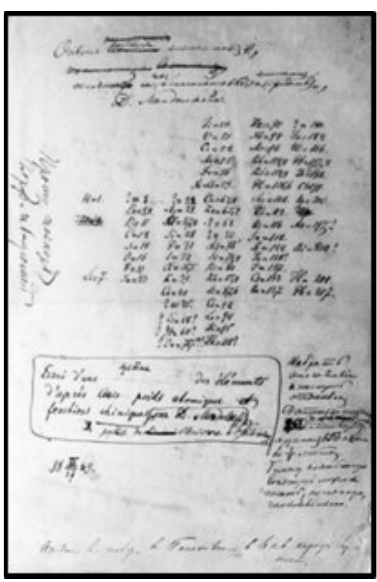
Figure 5. Mendeleev’s envelope with the first periodic table. Figure 6. The periodic table in Mendeleev’s first